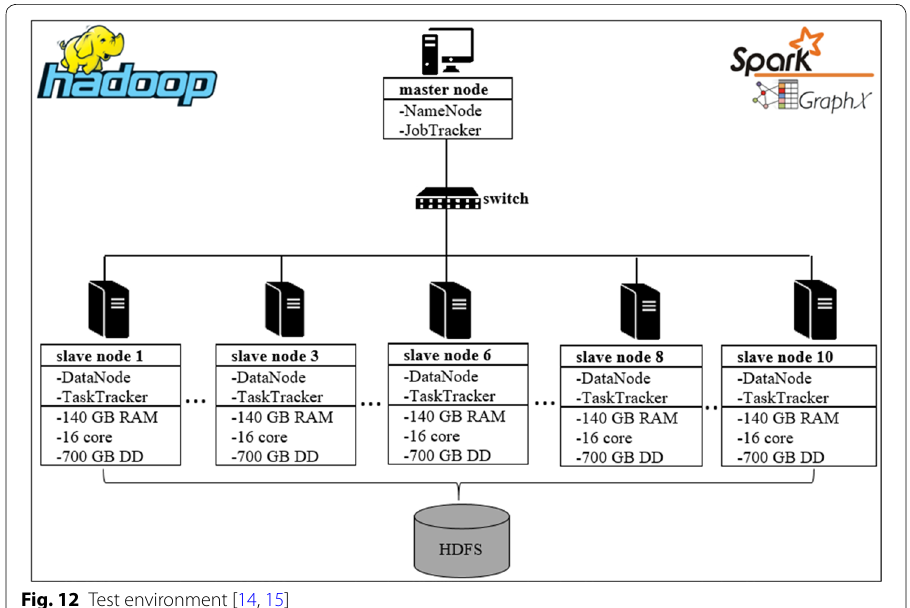
Fig. 12 Test environment [14,